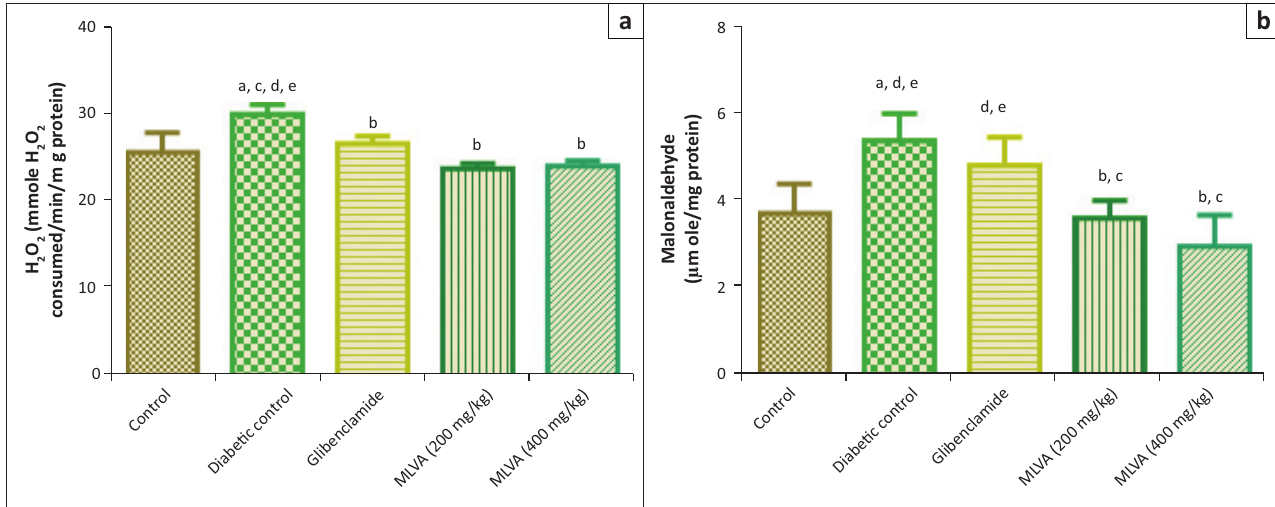
FIGURE 2: Effect of methanol leaf extract of Vernonia amygdalina (MLVA) on (a) hydrogen peroxide levels and (b) malonaldehyde content in intestinal tissue of alloxan- induced diabetic rats. Values are mean ± SD, n = 5, a p < 0.05 compared with control, b p < 0.05 compared with diabetic control, c p < 0.05 compared with glibenclamide, d p < 0.05 compared with MLVA, 200 mg/kg and e p < 0.05 compared with MLVA, 400